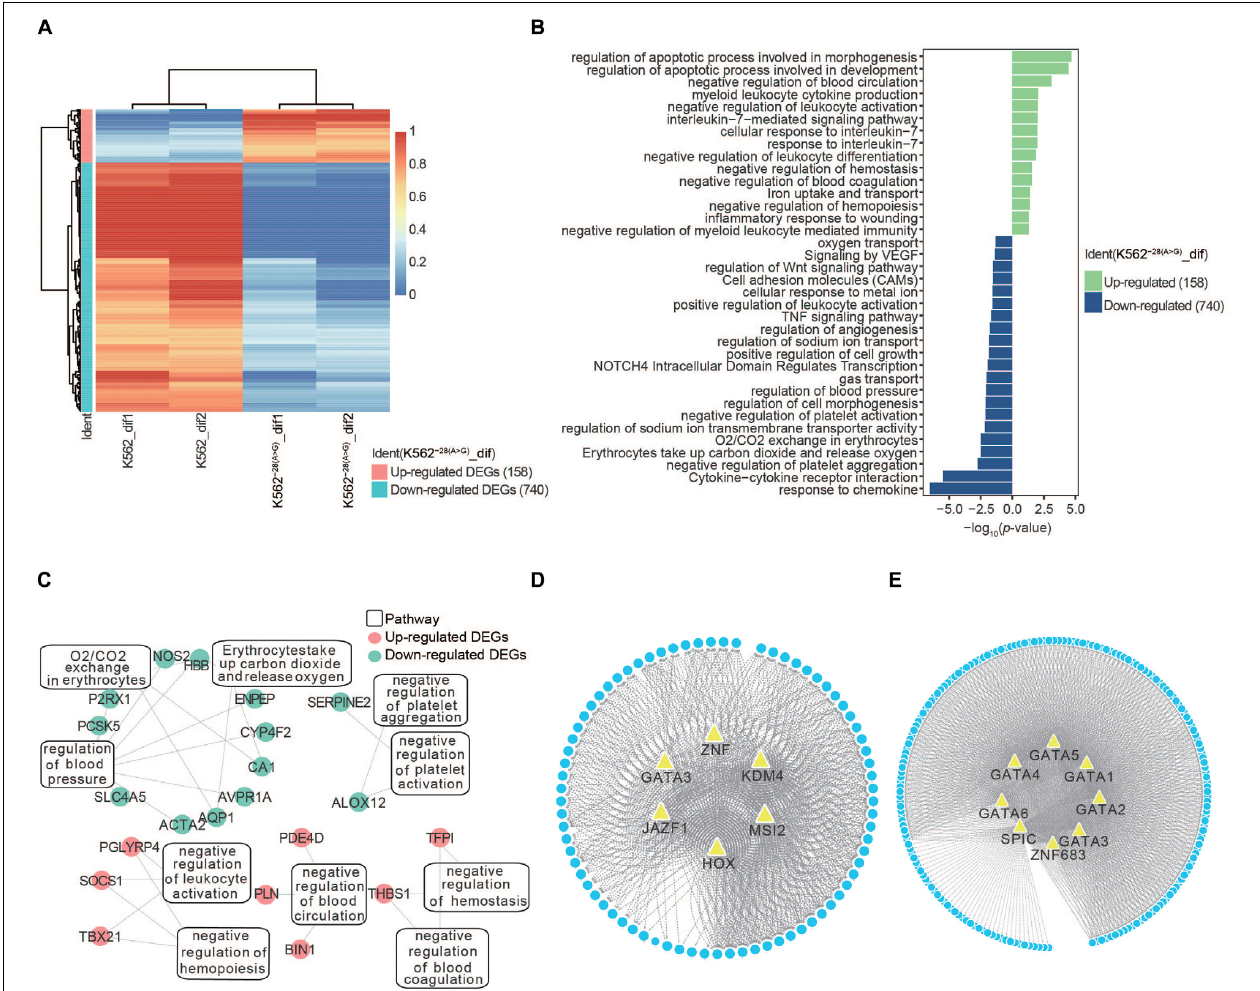
FIGURE 4 | Transcriptome analysis of DEGs in K562 and K562 − 28 ( A > G ) cell lines after erythroid differentiation. (A) Heat map shows DEGs in K562 − 28 ( A > G ) compared to K562 after differentiation. (B) Pathway analysis of K562 − 28 ( A > G ) compared to K562 after differentiation. The upregulated pathways are shown in green, and the downregulated pathways are shown in blue. (C) Enriched pathways and their DEGs in O 2 /CO 2 exchange in erythrocytes, negative regulation of hemopoiesis, as well as negative regulation of hemostasis. Upregulated DEGs are shown in red, and downregulated DEGs are shown in blue. (D) The prediction of TFs in K562 after differentiation. (E) The prediction of TFs in K562 − 28 ( A > G ) after